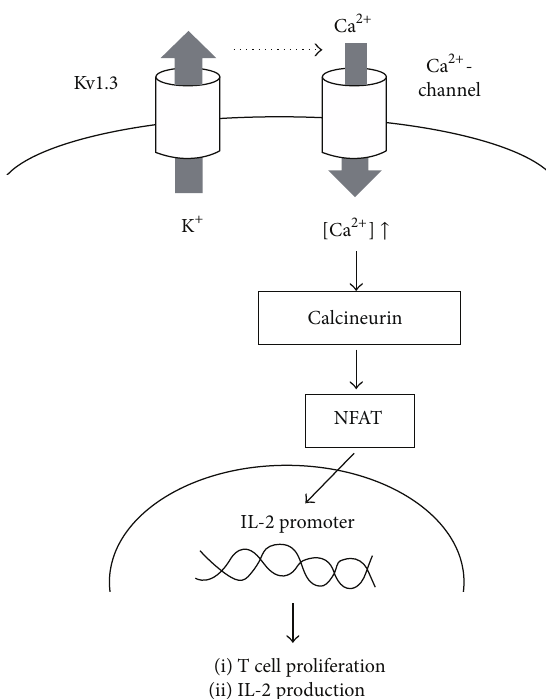
Figure 1: Kv1.3-channel-induced activation pathway of T lym- phocytes. Kv1.3-channels expressed in T lymphocytes facilitate the calcium influx necessary to trigger the lymphocyte activation and proliferation. The rise in the intracellular calcium concentration stimulates the phosphatase calcineurin activity, which then dephos- phorylates nuclear factor of activated T cells (NFAT), enabling it to accumulate in the nucleus and bind to the promoter of the gene encoding interleukin 2